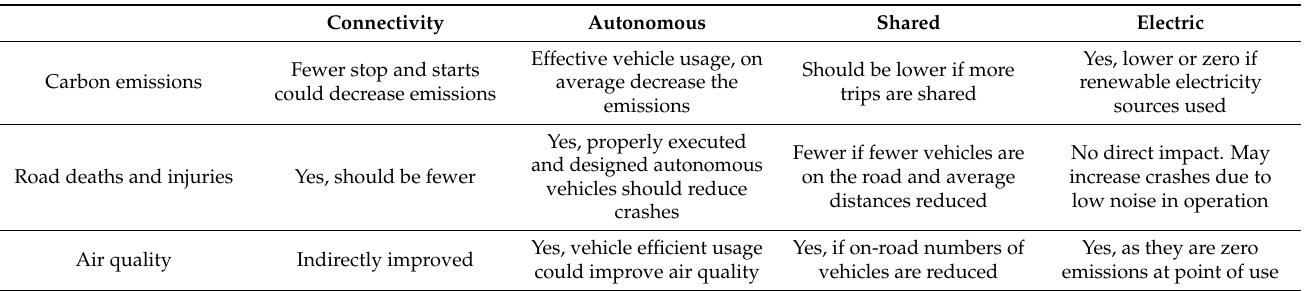
Table 1. Issues and benefits from CASE